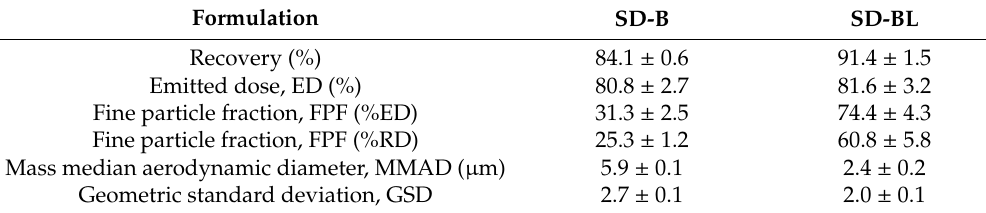
Table2. Aerosolizationperformanceofthespray-driedbedaquiline(withorwithout l